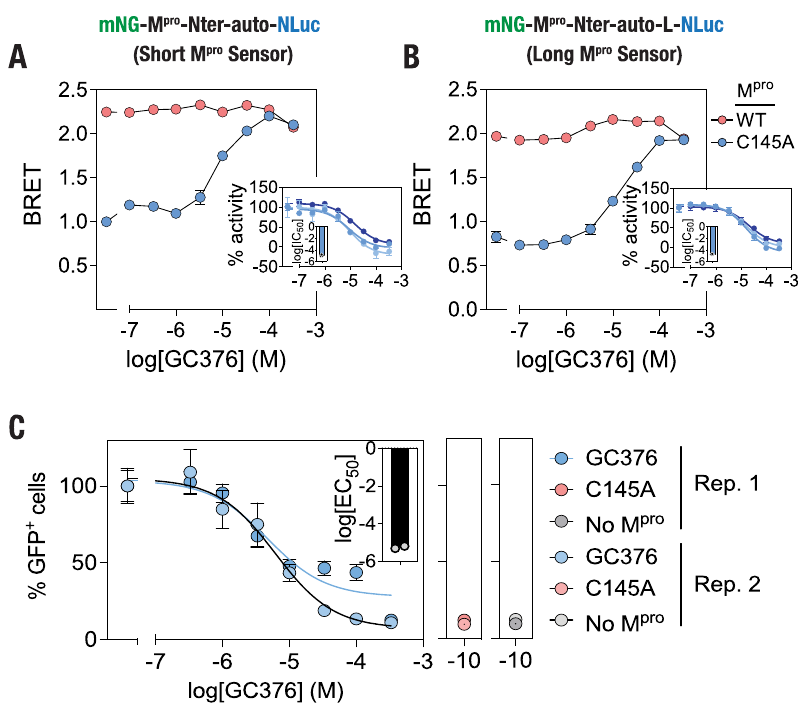
Fig. 5 M pro inhibition monitored in live cells using the BRET-based M pro sensors. A , B Graphs showing GC376-mediated inhibition of M pro proteolytic cleavage of the short ( A ) and long ( B ) M pro sensor in live cells. Data shown are mean ± S.D. from a representative of three independent experiments, with each experiment performed in triplicates. Insets: graphs showing percentage proteolytic activity of WT M pro in live cells (mean± S.D.) and fi tted to sigmoidal dose – response curve from three independent experiments. Bar graphs in the insets show log(IC 50 ) obtained from the three experiments. C Graph showing % GFP + cells expressing the FlipGFP-based M pro sensor and wild-type M pro at the indicated concentrations of GC376. Inset, graph showing log(IC 50 ) values (mean of two independent experiments). Outsets, graphs showing % GFP + cells expressing the C145A mutant M pro (left) or in the absence of M pro (right). Data shown are mean of two independent experiments, with each experiment performed in cleavage peptides, including the linker region, of the Mpro sensor (short cleavage peptide aa seq: EFGTENLYAVLQSGFRGSGGS, long cleavage peptide aa seq: